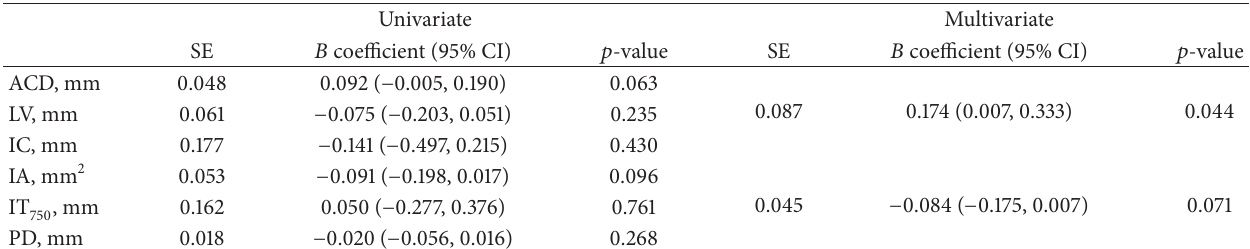
) assessed pre-LPI in the BG subjects. (AOD 750